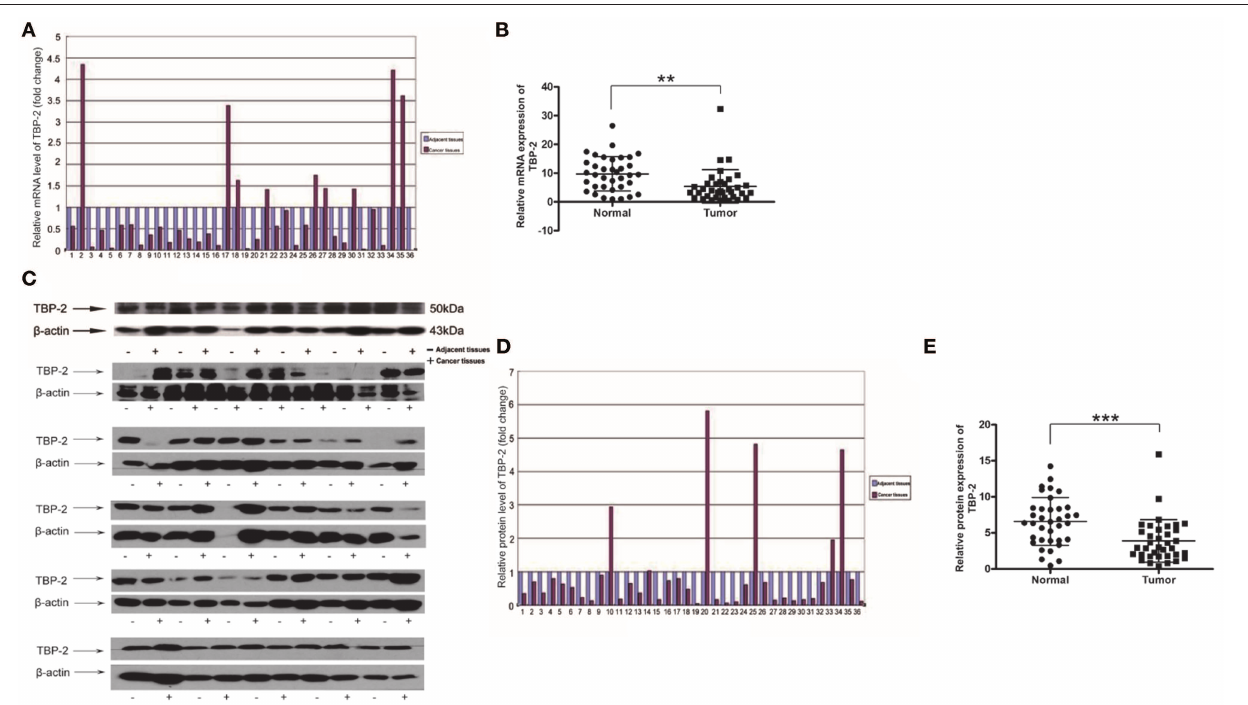
FIGURE 2 | The TBP-2 mRNA and protein levels in lung cancer tissues. (A,B) TBP-2 mRNA level in lung cancer tissues and adjacent non-cancerous tissues of 36 patients (** P < 0.01, two-tailed unpaired Student’s t test). (C–E) TBP-2 protein expression in lung cancer tissues and adjacent noncancerous tissues of 36 patients (*** P < 0.001, two-tailed unpaired Student’s t test).